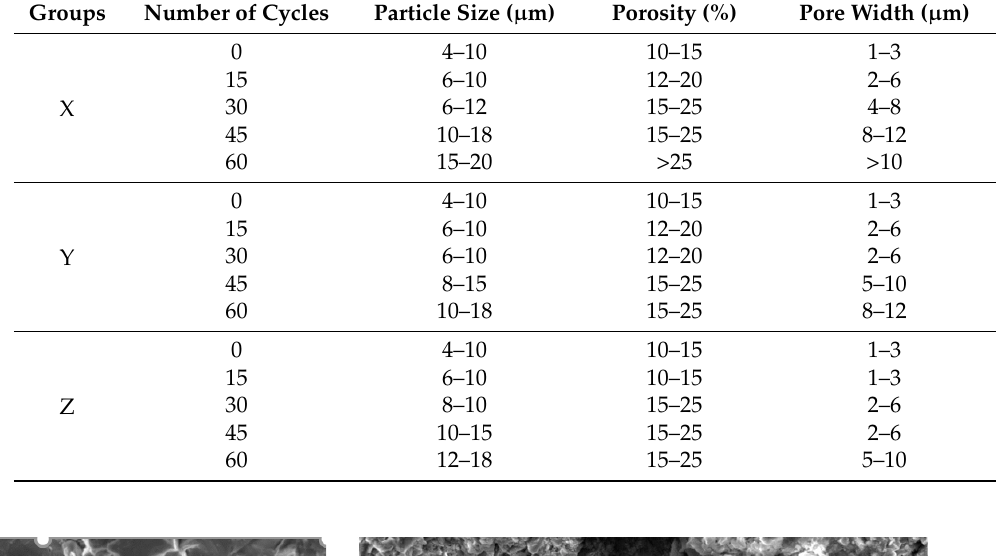
Table 1. SEM parameters of the samples.